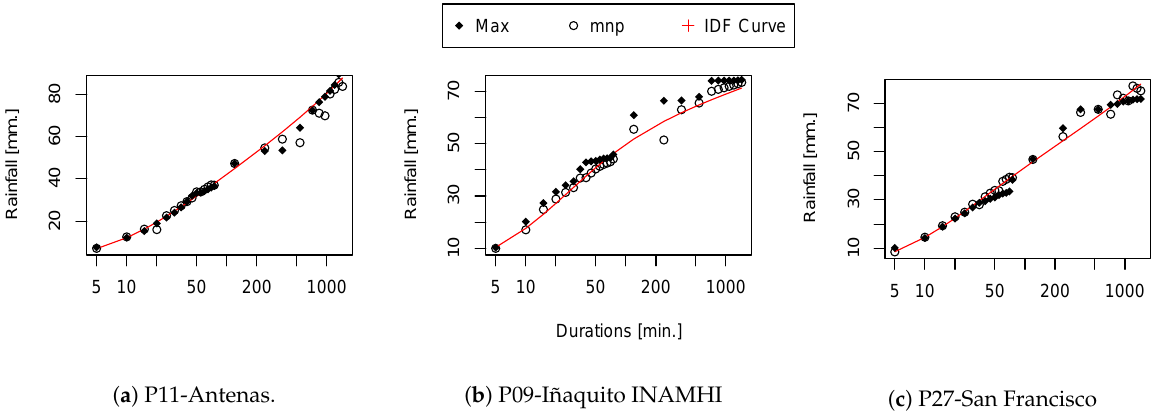
Figure 9. Maximum recorded rainfall at several t d , accumulated rainfall obtained through mnp function and the estimated rainfall of the IDFs at T = 20